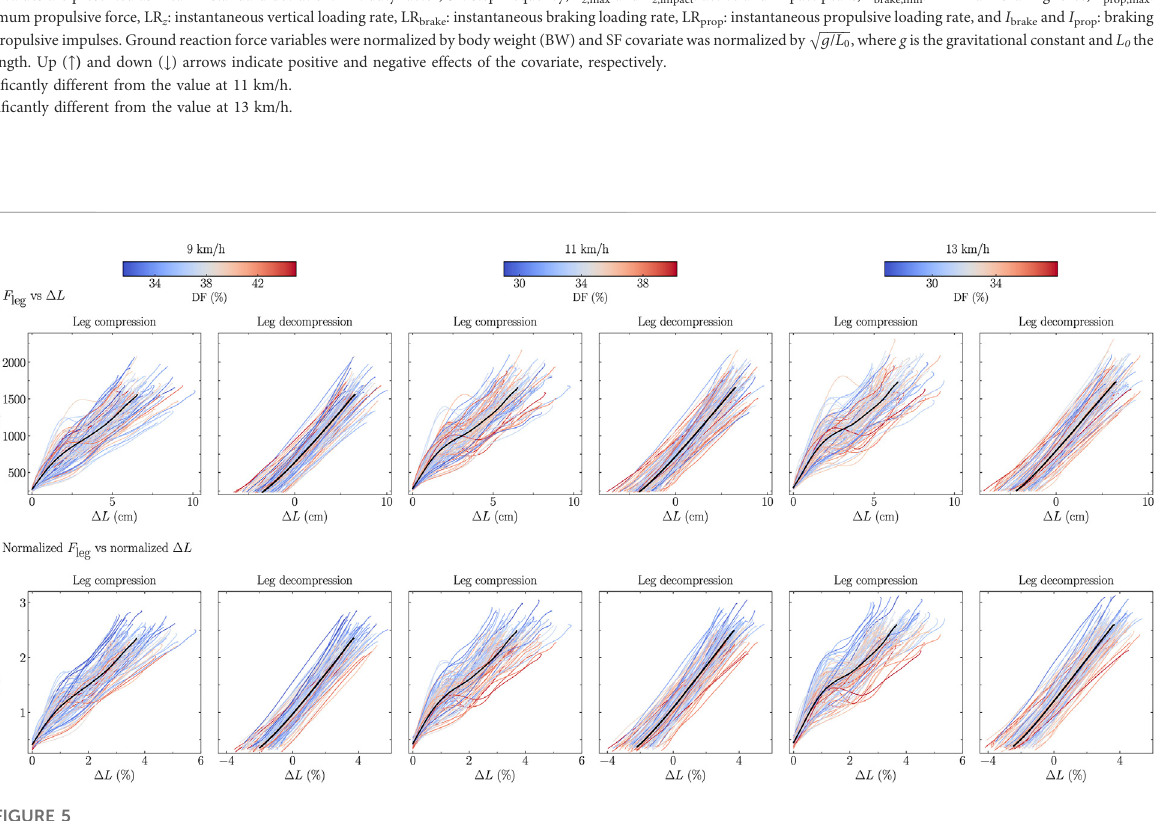
FIGURE 5 Force-lengthrelationship,i.e., groundreaction forceprojectedalong theleg( F leg )as functionofthelegcompression/decompression,for each participant [the color depends on the duty factor (DF) value] and for the mean (black line) over all participants during the running stance phase, at three running speeds, and expressed using (A) SI units and (B) normalized units, i.e., body weight (BW) for F leg and percentage of runners ’ height for leg